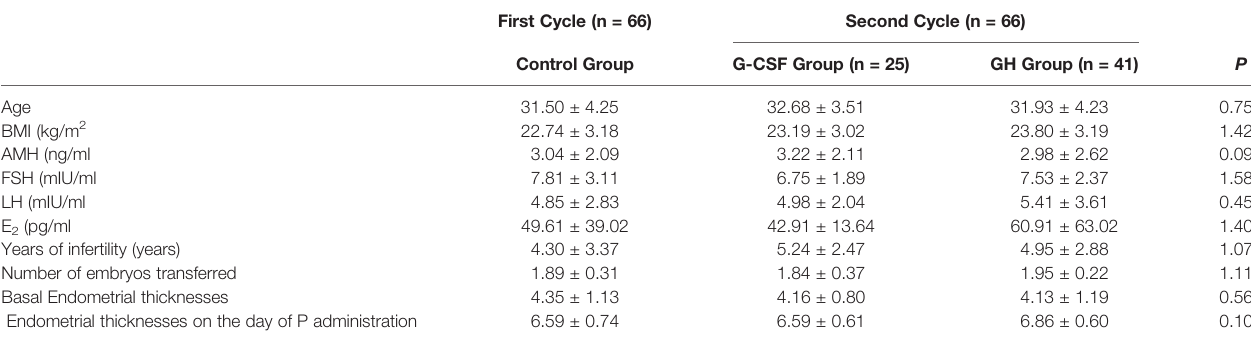
TABLE 1 | The comparison of First Cycle and Second Cycle.